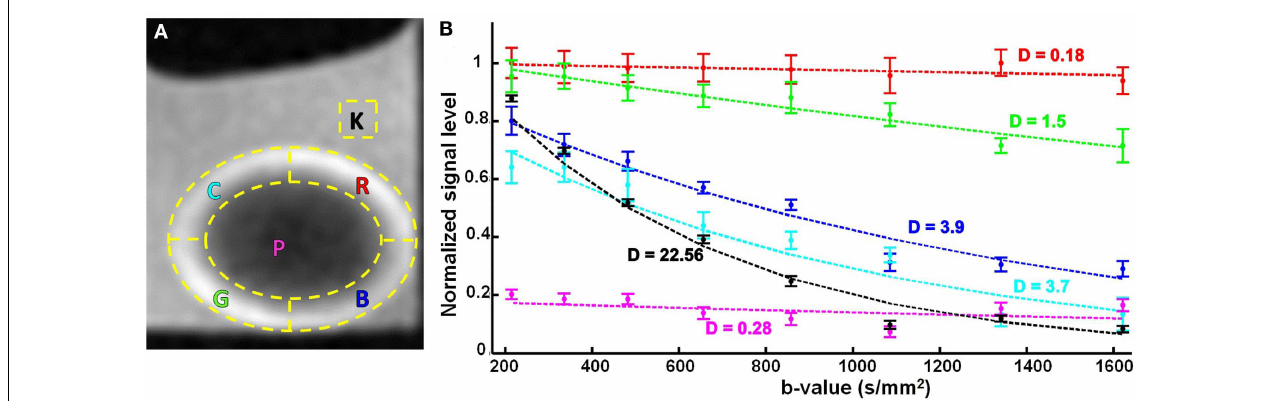
predominantly radially in the lens tissue (see Figure 1C ); in contrast, ROIs B and C sample areas where the direction of the diffusion gradients runs more tangentially to the lens curvature. (B) Graphs of the mean and standard error of the signal measured in the respective color-coded ROIs for eight different b -values.The dashed lines represent exponential curves fitted to estimate the diffusion coefficients (labeled D near each curve) in the ROIs with respect to the applied diffusion gradient.The values for D are given in 10 − 3 mm 2 /s.The T E in these experiments was